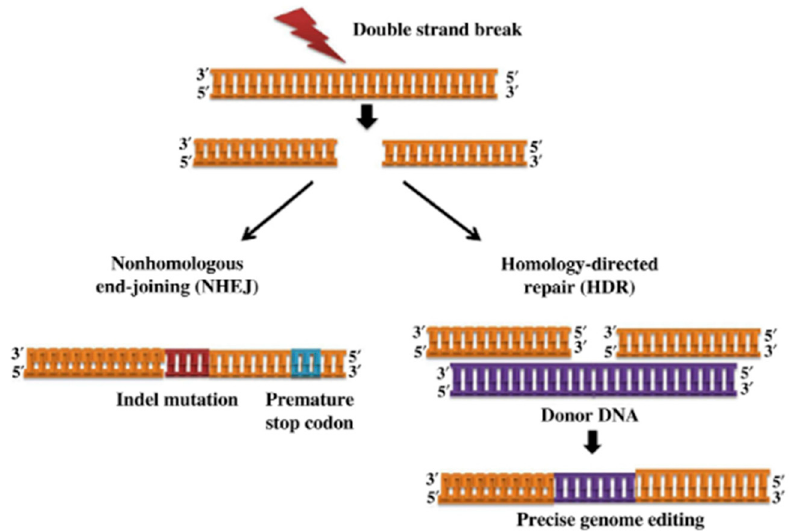
Figure 2. DNA double-strand breaks into genomic loci are repaired by various strategies, including nonhomologous end-joining (NHEJ) or homology-directed repair (HDR) pathway